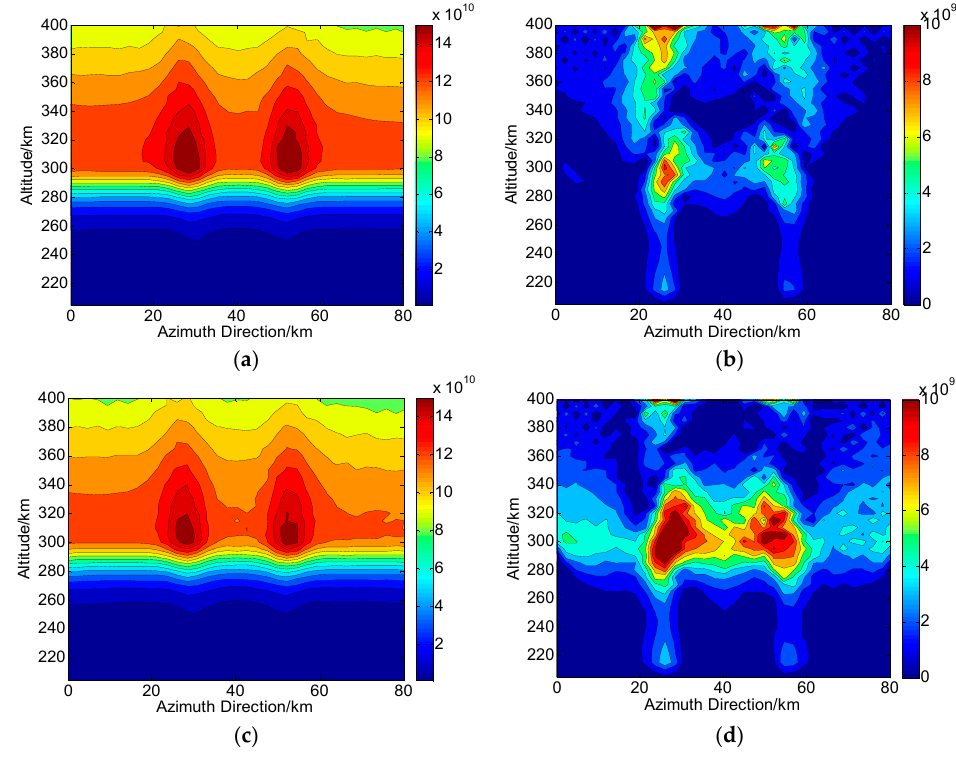
Figure 5. Two-dimensional CIT reconstructions without system errors in Changbai. ( a , c ) are the reconstructed results based on proposed and traditional CIT methods, respectively. ( b , d ) are the corresponding absolute deviations between the true and reconstructed results. The unit of the electron density is electrons · m − 3